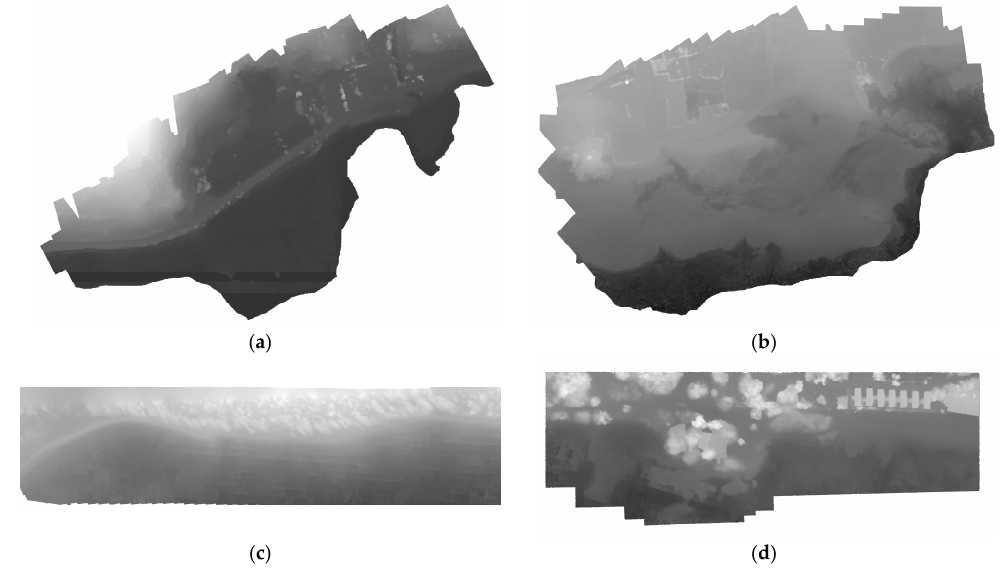
Figure 5. The merged DSM for Amathounta ( a ), Agia Napa ( b ), Cyclades-1 ( c ), and Cyclades-2 ( d ) test